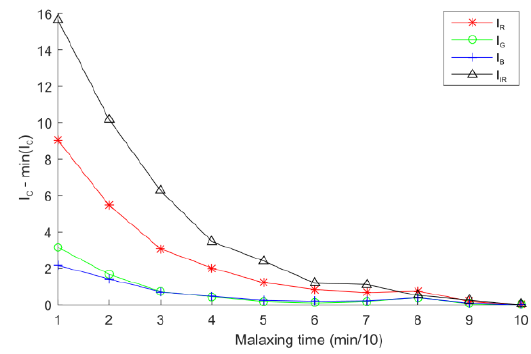
Figure 10. Viscosity index for different channels versus malaxing time.